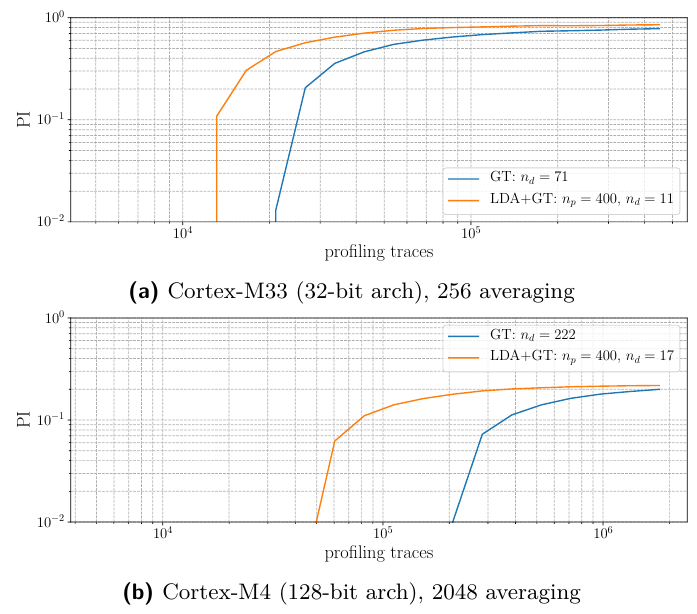
Figure 16: PI for the best models we found with and without using linear